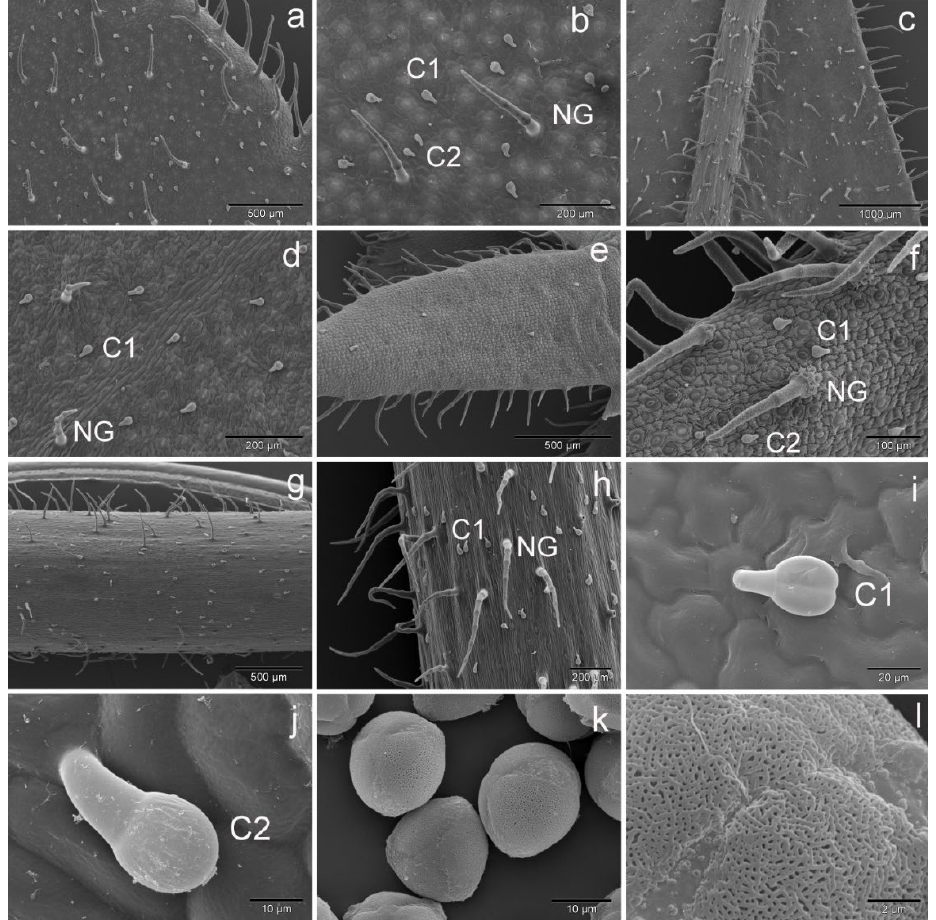
Figure 6. SEM micrographs of Barrelier’s Speedwellwith different types and distribution of trichomes ( a – j ) on the adaxial ( a , b ) and abaxial ( c , d ) leaf surface, calyx ( e , f ), and stem ( g , h ). Non-glandular trichomes (NG), subtype 1 (C1) and subtype 2 (C2) of capitate trichomes. SEM micrographs of pollen ( k , l ) after critical point drying with appearance of exine surface ( l ).